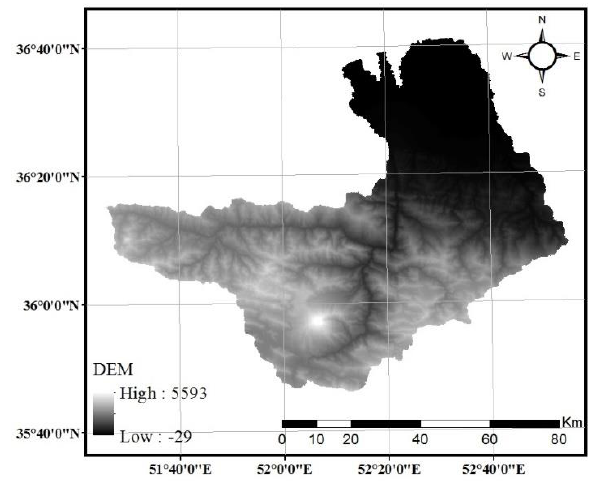
Figure 10. Digital elevation model of the Babol